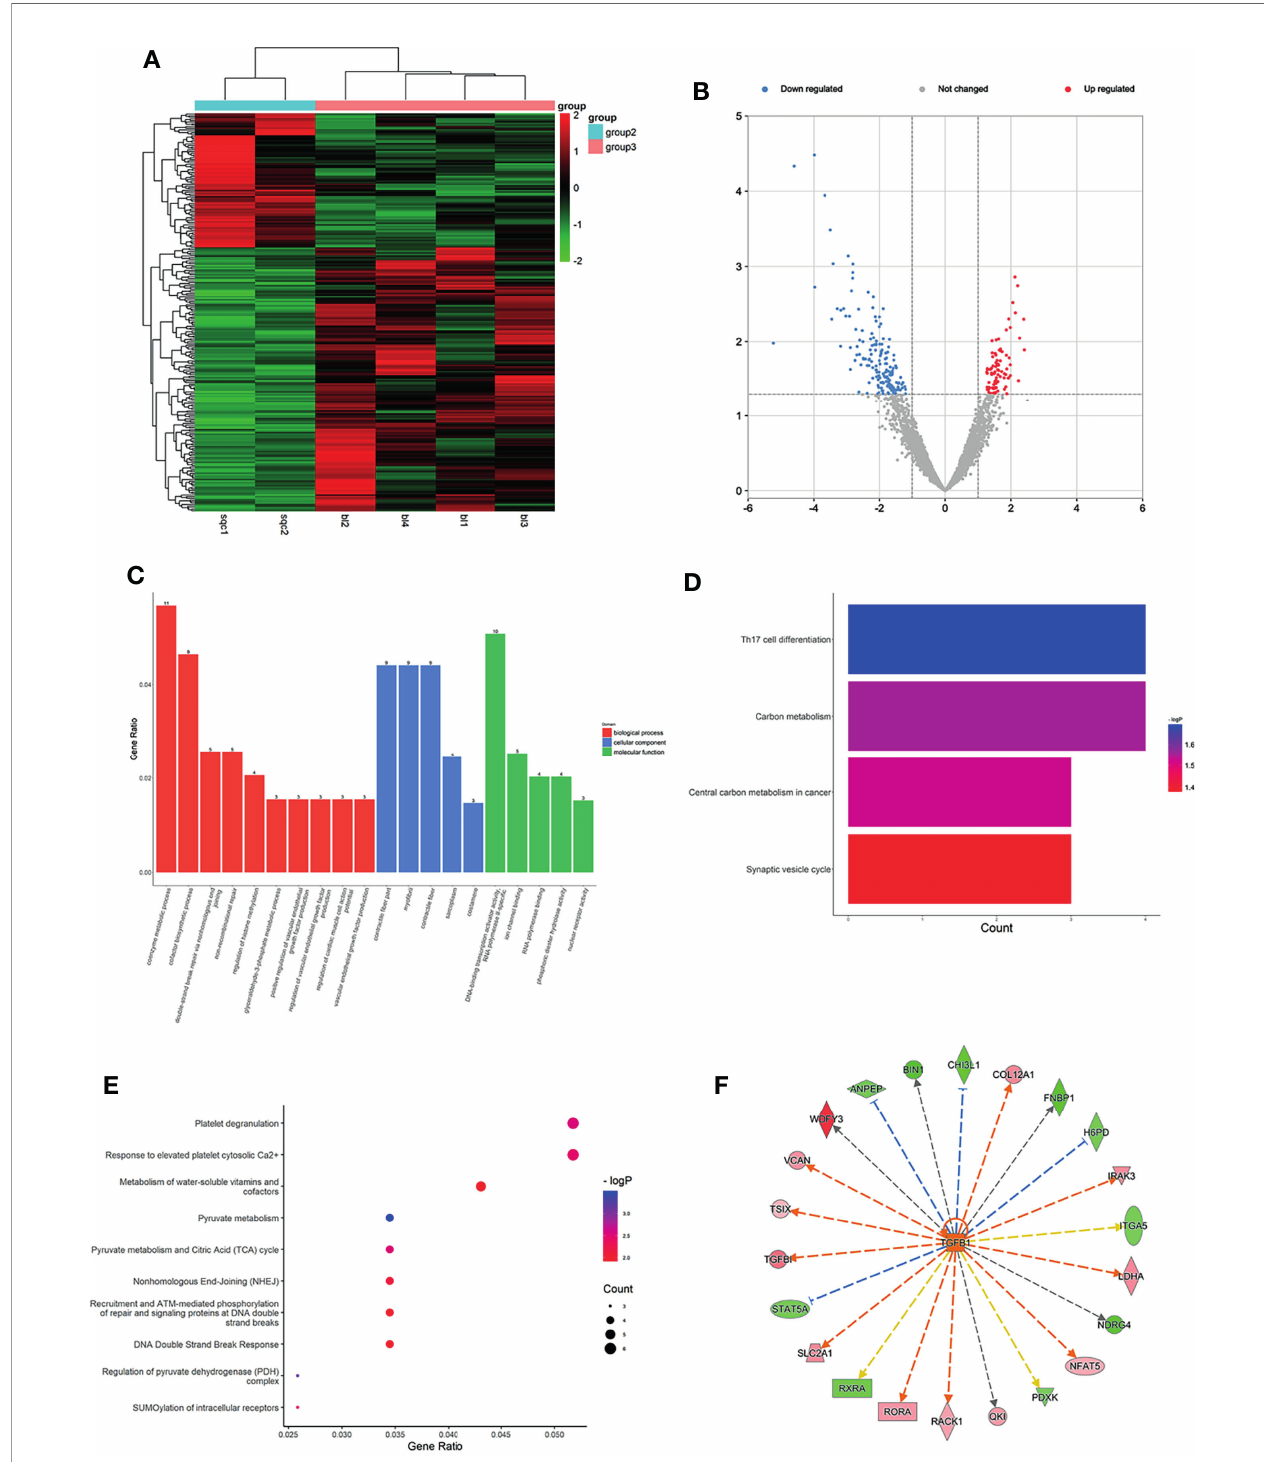
FIGURE 3 | Expression pro fi les of mRNAs in plasma between LUSC patients and LUH negative controls. (A) Heatmap of differentially expressed mRNAs in LUSC patients and controls (group 2, LUSC plasma; group 3, LUH plasma). (B) Volcano plot of differentially expressed mRNAs (read, upregulated genes; green, downregulated genes). (C) Enrichment analysis of GO terms and pathways of the differentially expressed mRNAs. (D) The top 10 KEGG terms for the differentially expressed mRNAs between two groups. (E) Reactome pathway analysis was performed to evaluate the underlying pathway. (F) Ingenuity pathway analysis predicted TGFB1 as a major activation of transcription regulator in